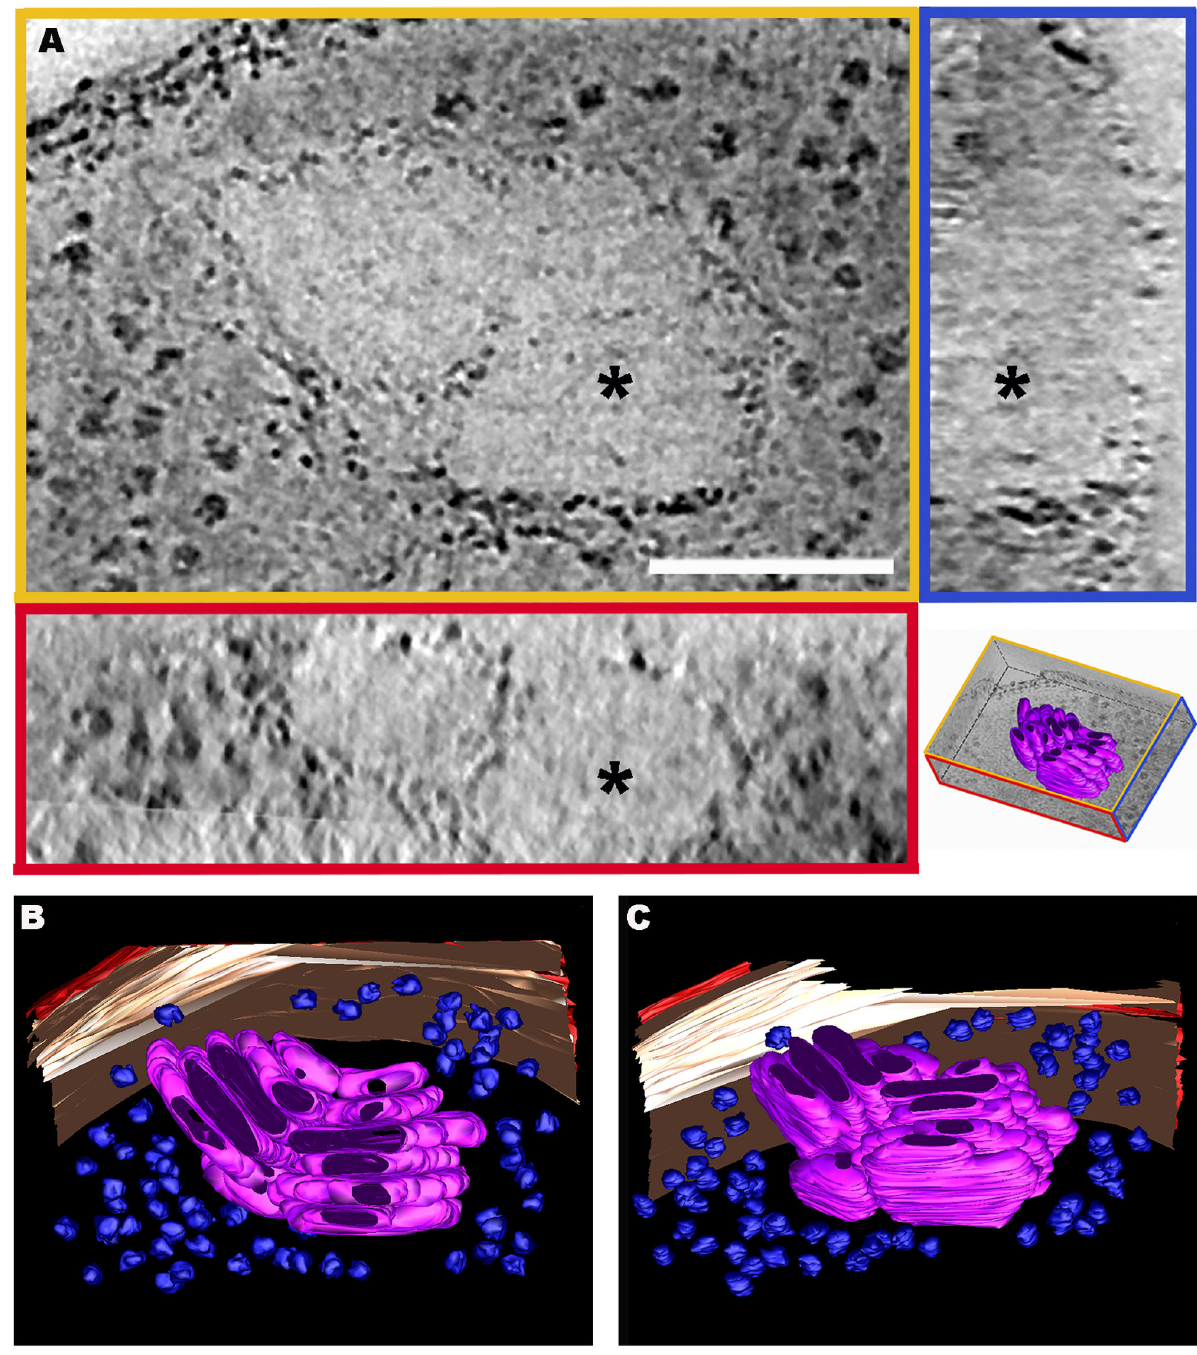
Figure 3. 3D visualization of stacks observed in P. deceptionensis M1 T cells after HPF-FS. (A) 2 nm tomogram slices from the XYZ views of a bbif-filtered tomogram reconstructed from a 250 nm Epon section. The asterisks correspond to the same point through the different views. Scale bar = 100 nm. The XY view (top-left image) shows a peripheral portion of the cytoplasm of a cell where two contiguous stacks can be visualized. The YZ view (top right image) shows the clustered sticks from the stack on the right in the XY view. The XZ view (bottom left image) reveals two stacked units as oval structures. The bottom right picture corresponds to a scheme of the view’s distribution in the tomogram. (B–C) Two different views from the segmentation of the tomogram observed in (A), which reveal the 3D structure of the stacks within the tomogram as groups of oval discs. In red, the outer membrane; in cream-color, the PM; in blue, the ribosomes; and in pink, the discs. doi: 10.1371/journal.pone.0073297.g003 PLOS ONE |